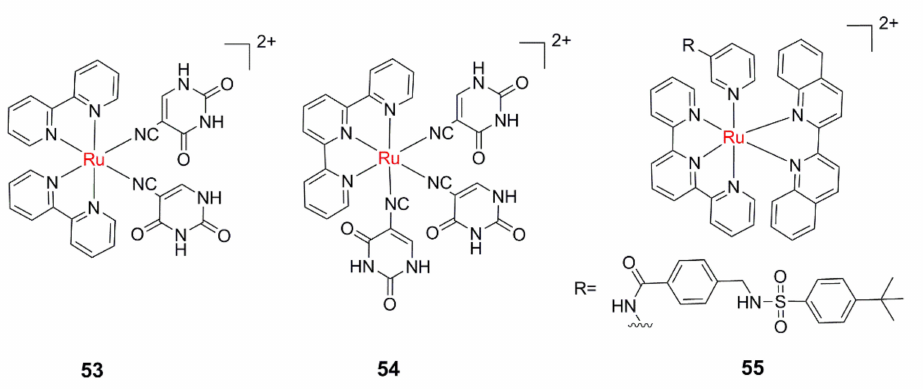
Figure 8. Ru(II) PACT agents with photolabile bioactive